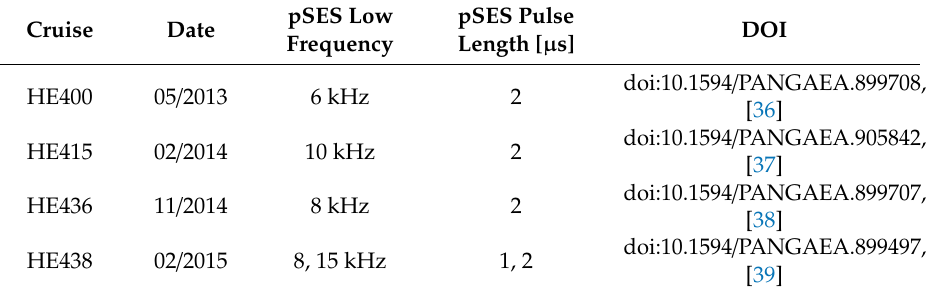
Table 1. Parametric sediment echo sounder (pSES) data sets, settings, and respective databases.